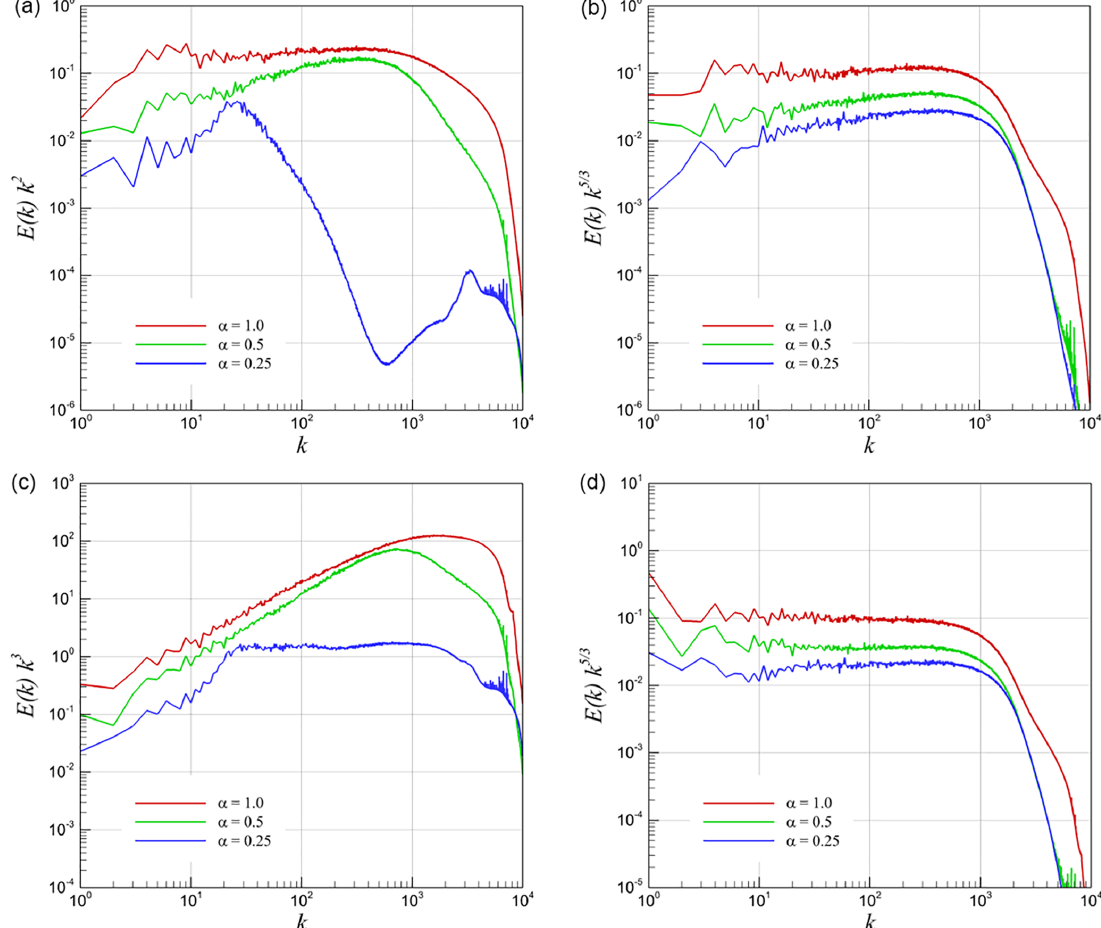
Figure 16. Helmholtz decomposition of energy spectra into compressive (curl-free) and solenoidal (divergence-free) parts for 2-D KHI turbulence. (a) Compensated compressive spectra from u , (b) compensated compressive spectra from ω = spectra from u , and (d) compensated solenoidal spectra from ω =